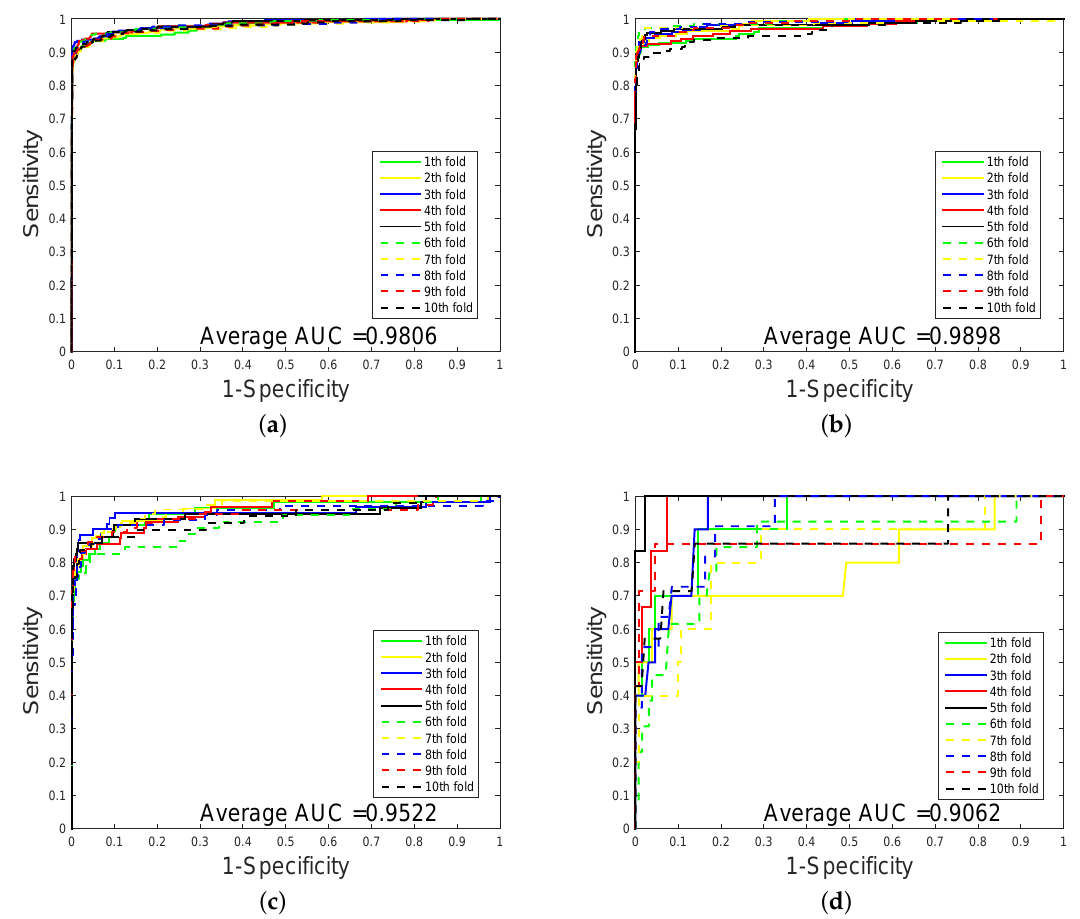
Figure 3. ROC of imbalanced datasets by 10-fold cross-validation; ( a ) Enzyme’s ROC curve with network feature; ( b ) IC’s ROC curve with network feature; ( c ) GPCR’s ROC curve with network feature; ( d ) Nuclear receptor’s ROC curve with network